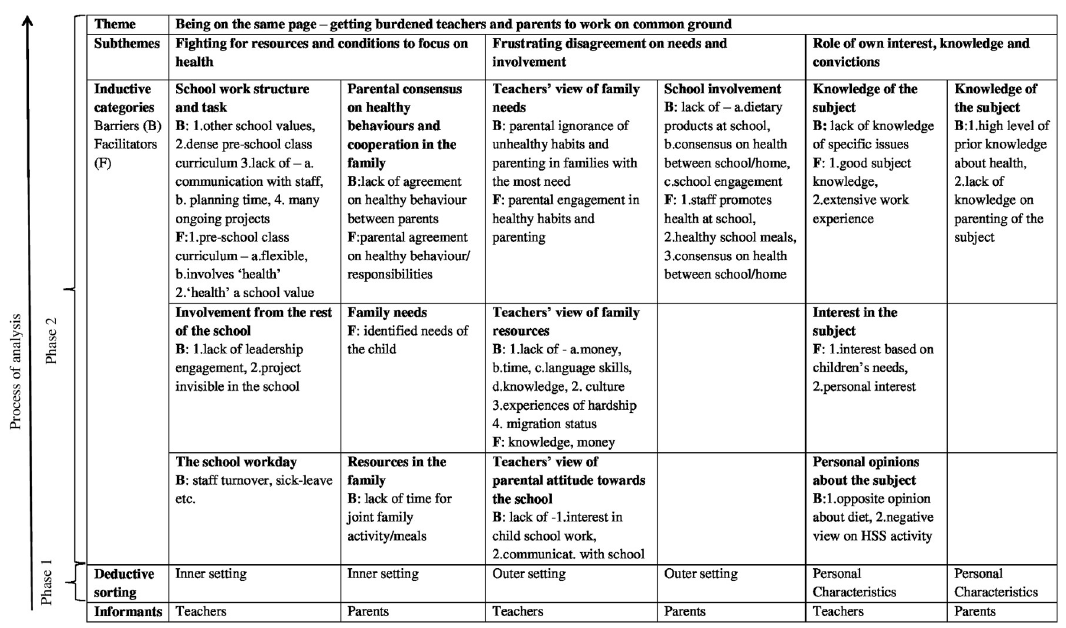
Fig 2. Description of analysis and findings. Phase 1: deductive sorting into CFIR domains, phase 2: inductive identification of categories, subthemes and theme. https://doi.org/10.1371/journal.pone.0224512.g002 PLOS ONE | https://doi.org/10.1371/journal.pone.0224512 November5,